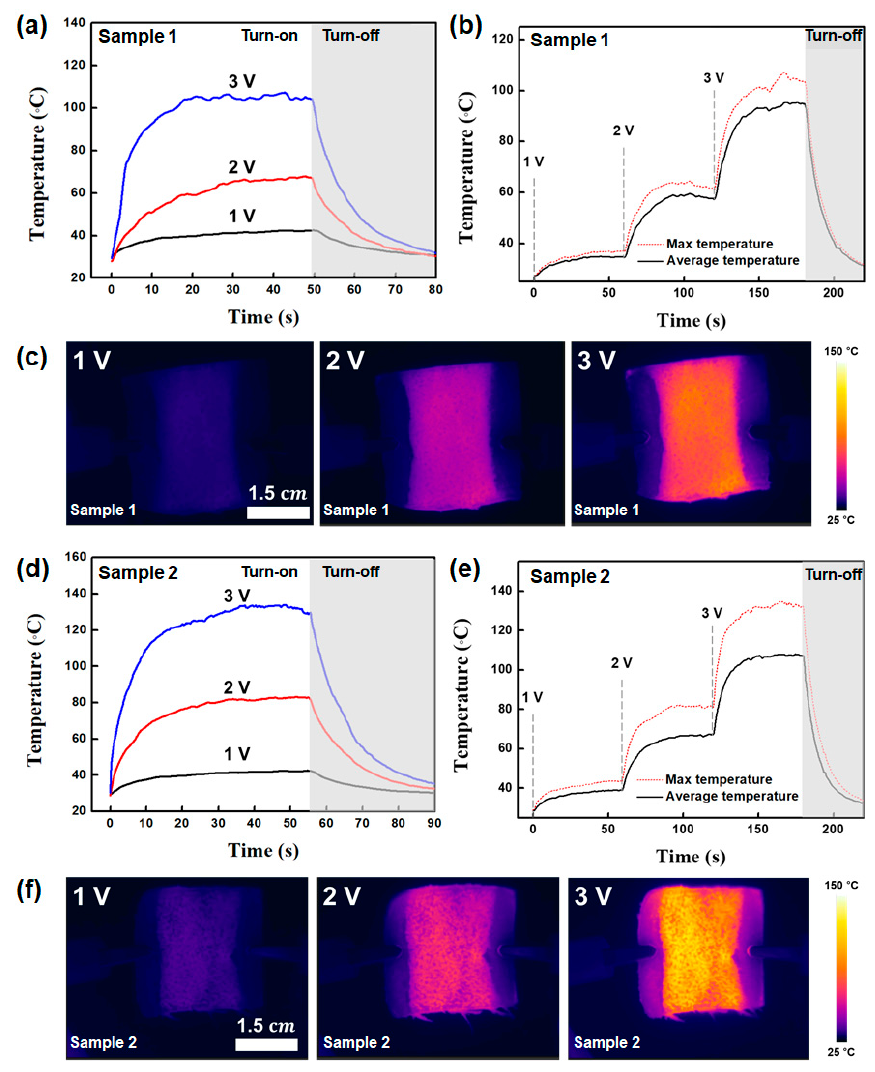
Figure 7. ( a ) Joule heating characterization, ( b ) maximum and average temperature, and ( c ) corresponding infrared images of sample 1 with an applied bias from 1 to 3 V. ( d ) Joule heating characterization, ( e ) maximum and average temperature, and ( f ) infrared images of sample 2 with a bias of 1 to 3 V.